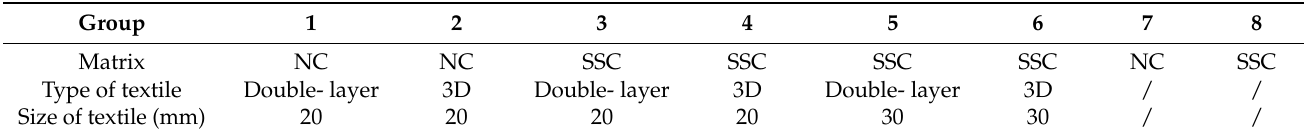
Table 3. Specimens for compression